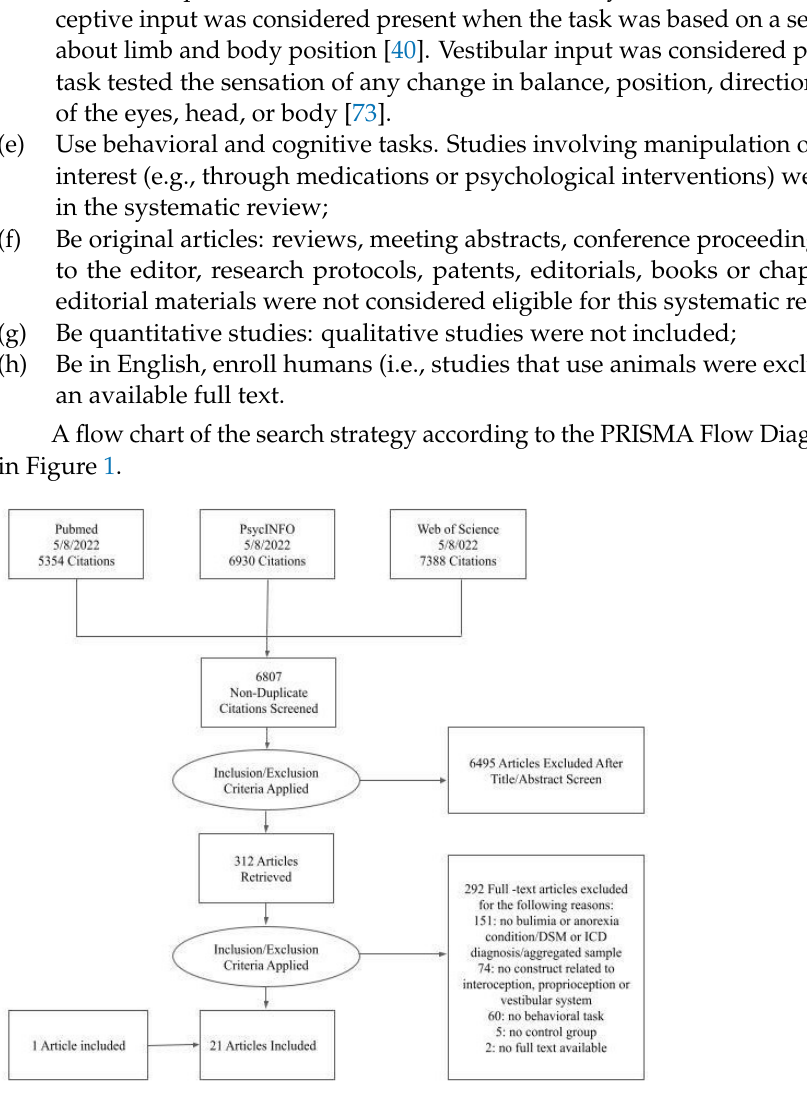
Figure 1. Flow chart of the systematic review. The figure illustrates the search strategy of the systematic review conducted under PRISMA guidelines.